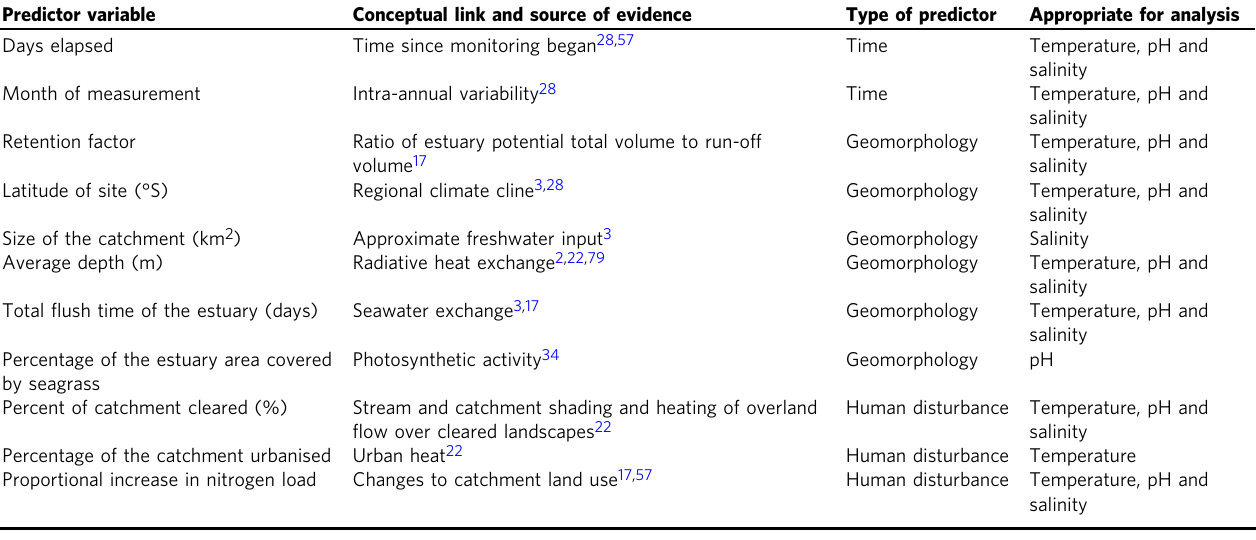
Table 1 Predictor variables used to determine the drivers of change in temperature, pH and salinity in east Australian